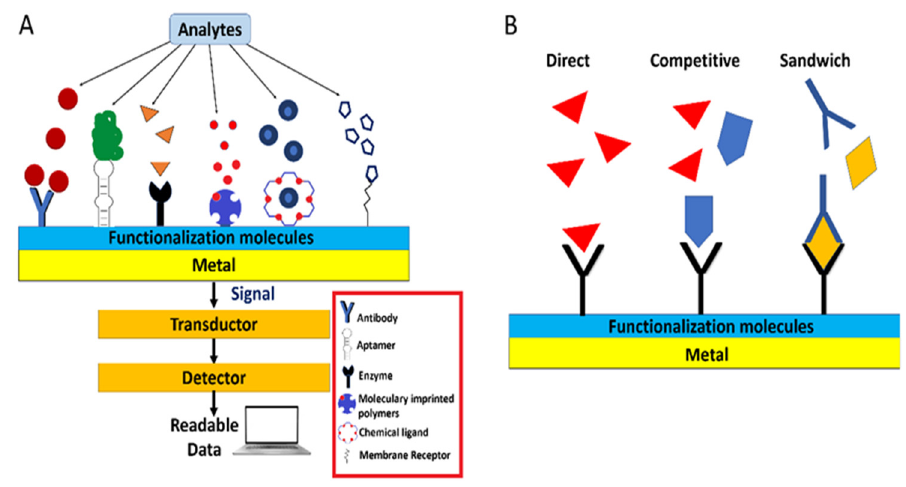
Figure 3. ( A ) Schematic representation of types of recognition elements and ( B ) Assay formats.